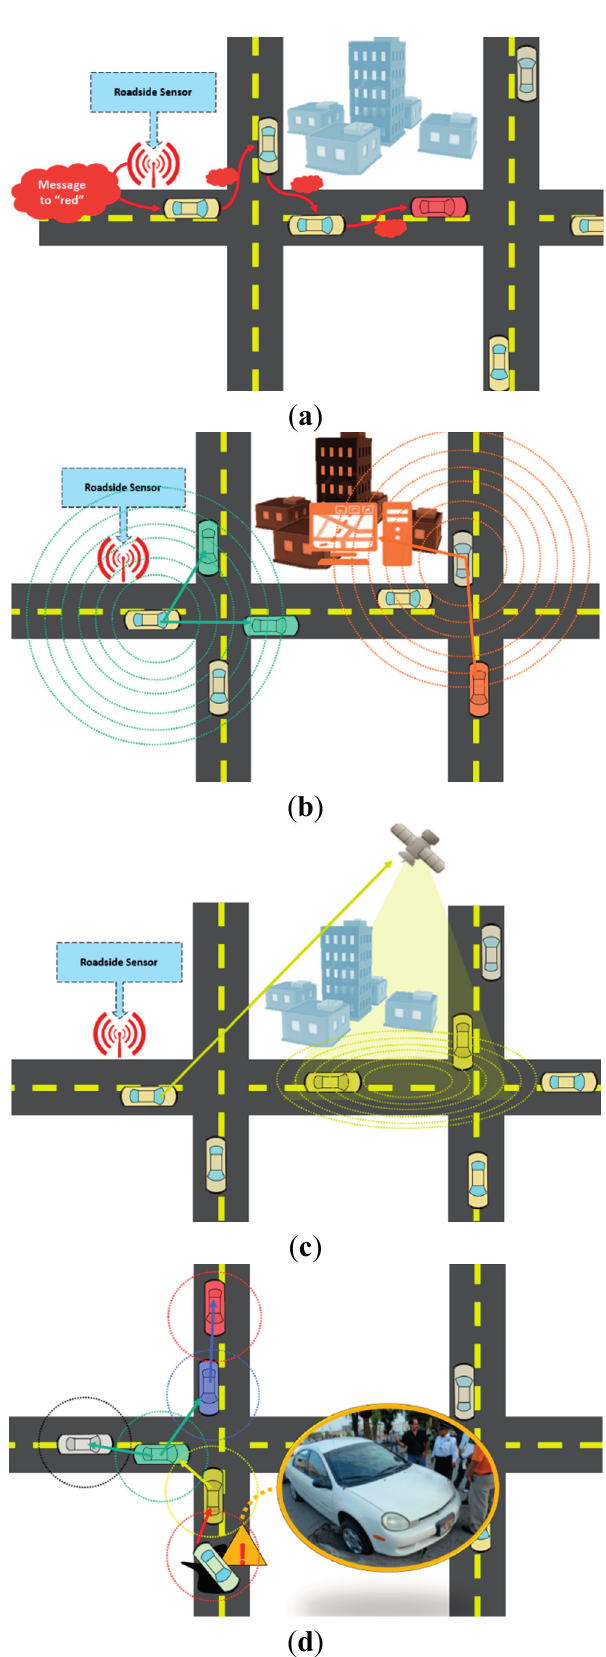
Figure 6. Supported mechanisms supported in vehicular networks. ( a ) Unicast communication; ( b ) Multicast communication; ( c ) Geocast communication; ( d ) Broadcast